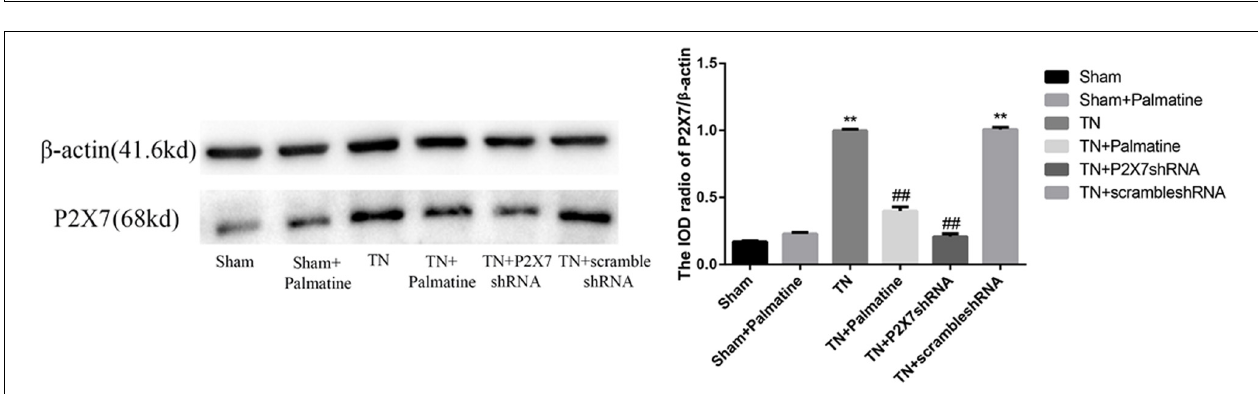
FIGURE 5 | The co-expression of P2X7 and GFAP in the intraoperative TGs of rats in each group was detected by immunofluorescence. The arrows point to glial cells that are immune-stained. Scale bar: 100 µ m. Values are mean ± SD, n = 6, * p < 0.05 and ** p < 0.01 vs. sham group, ## p < 0.01 vs. TN group.